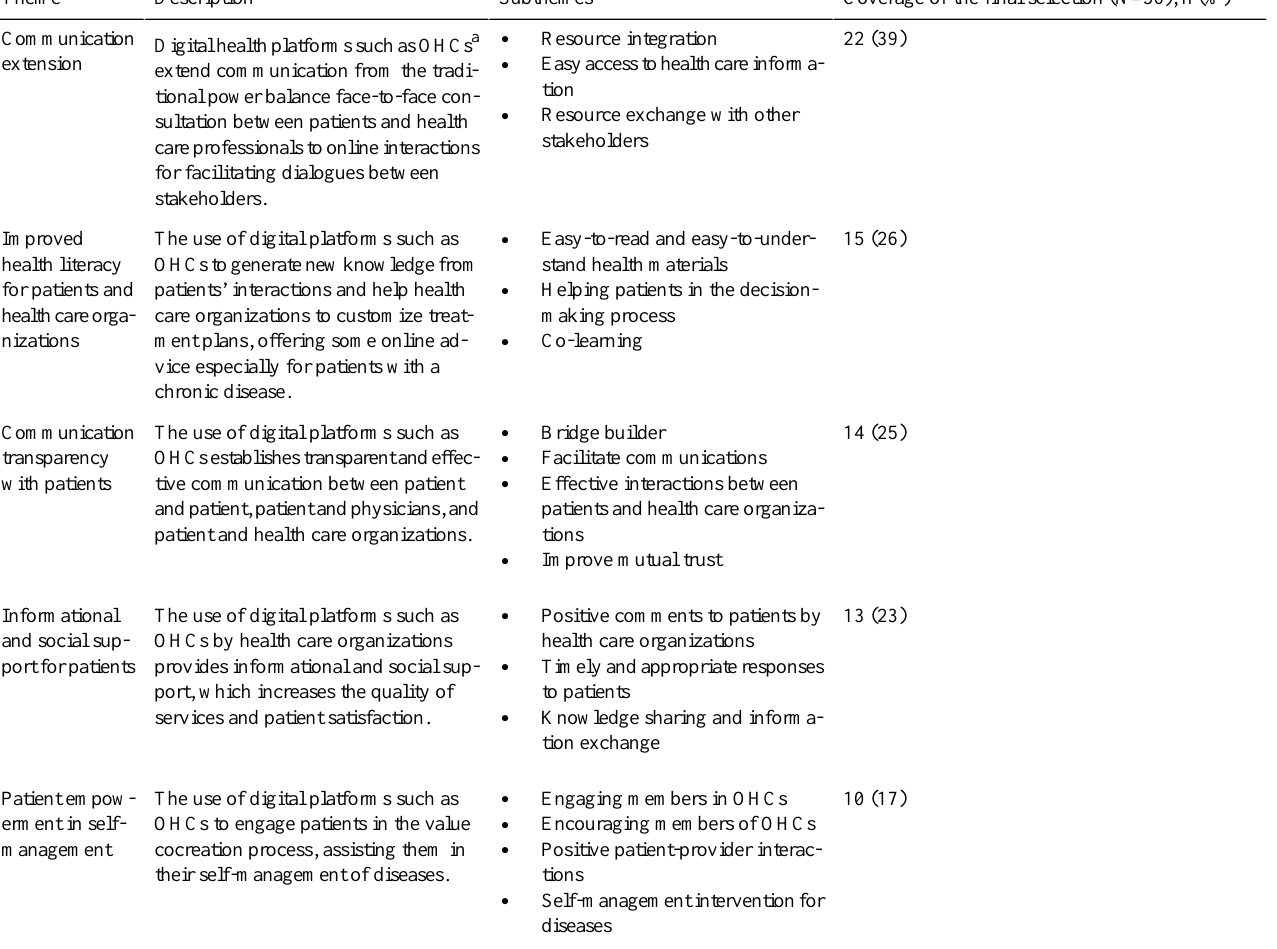
Table 1. Summary of the thematic analysis